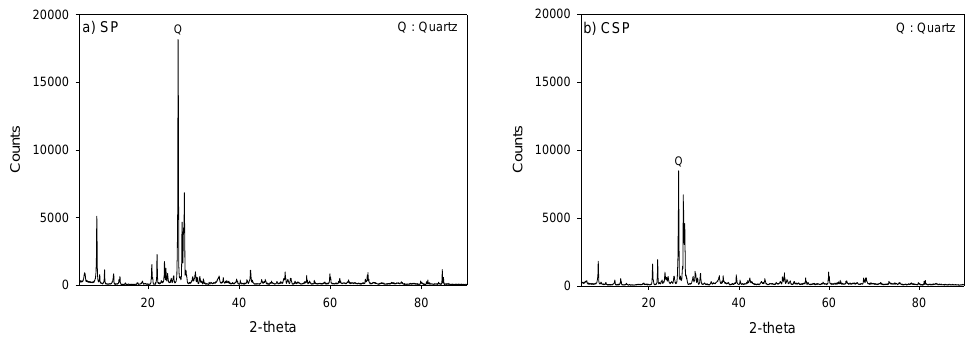
Figure 1. Results of XRD analyses of ( a ) stone powder (SP) and ( b ) chitosan-coated SP (CSP). Table 1. Surface area, pore volume, pore size, and pH of SP and CSP.